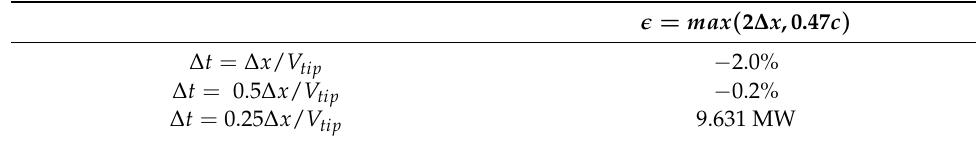
Table 4. Variation of power [MW] with increasing time-step ∆ t [sec]. Reference power corresponds to minimum value ∆ t = 0.25 ∆ x / V tip